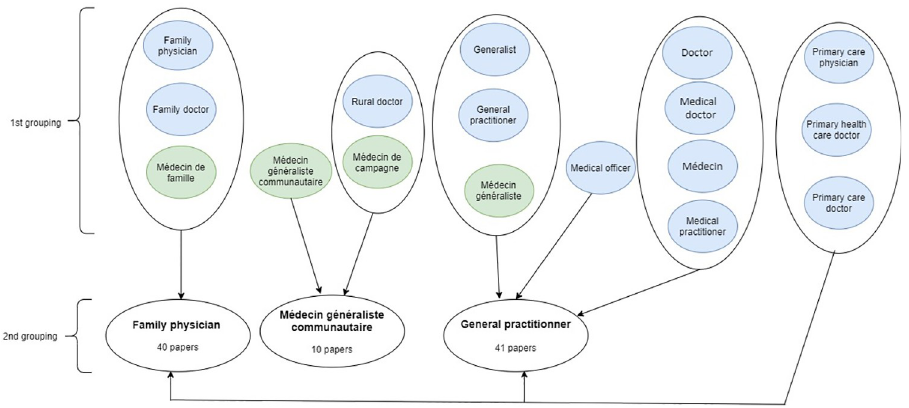
Fig 2. Categorisation of primary care